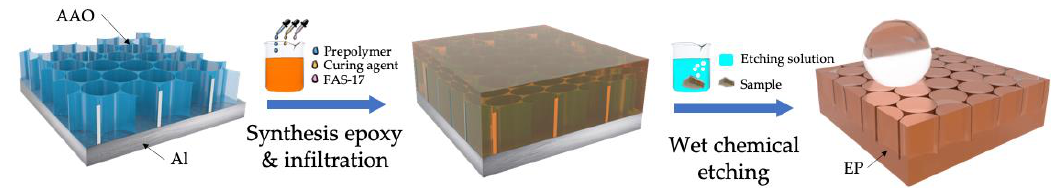
Figure 1. Schematic presentation of the fabrication process of the nano-pillar structured EP surface.